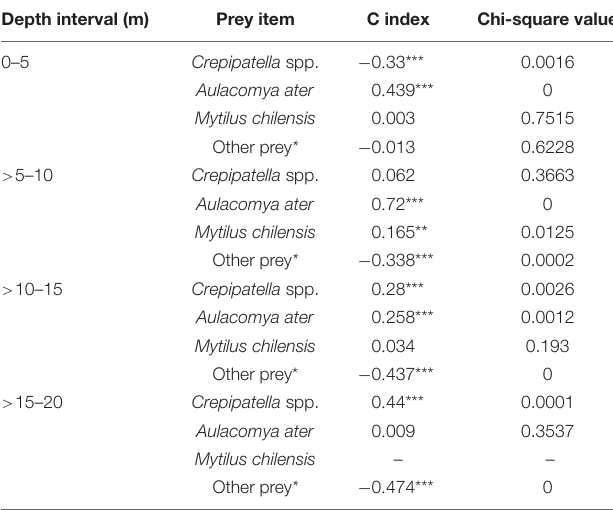
TABLE 4 | Electivity values (C index) for feeding in the sea star Cosmasterias